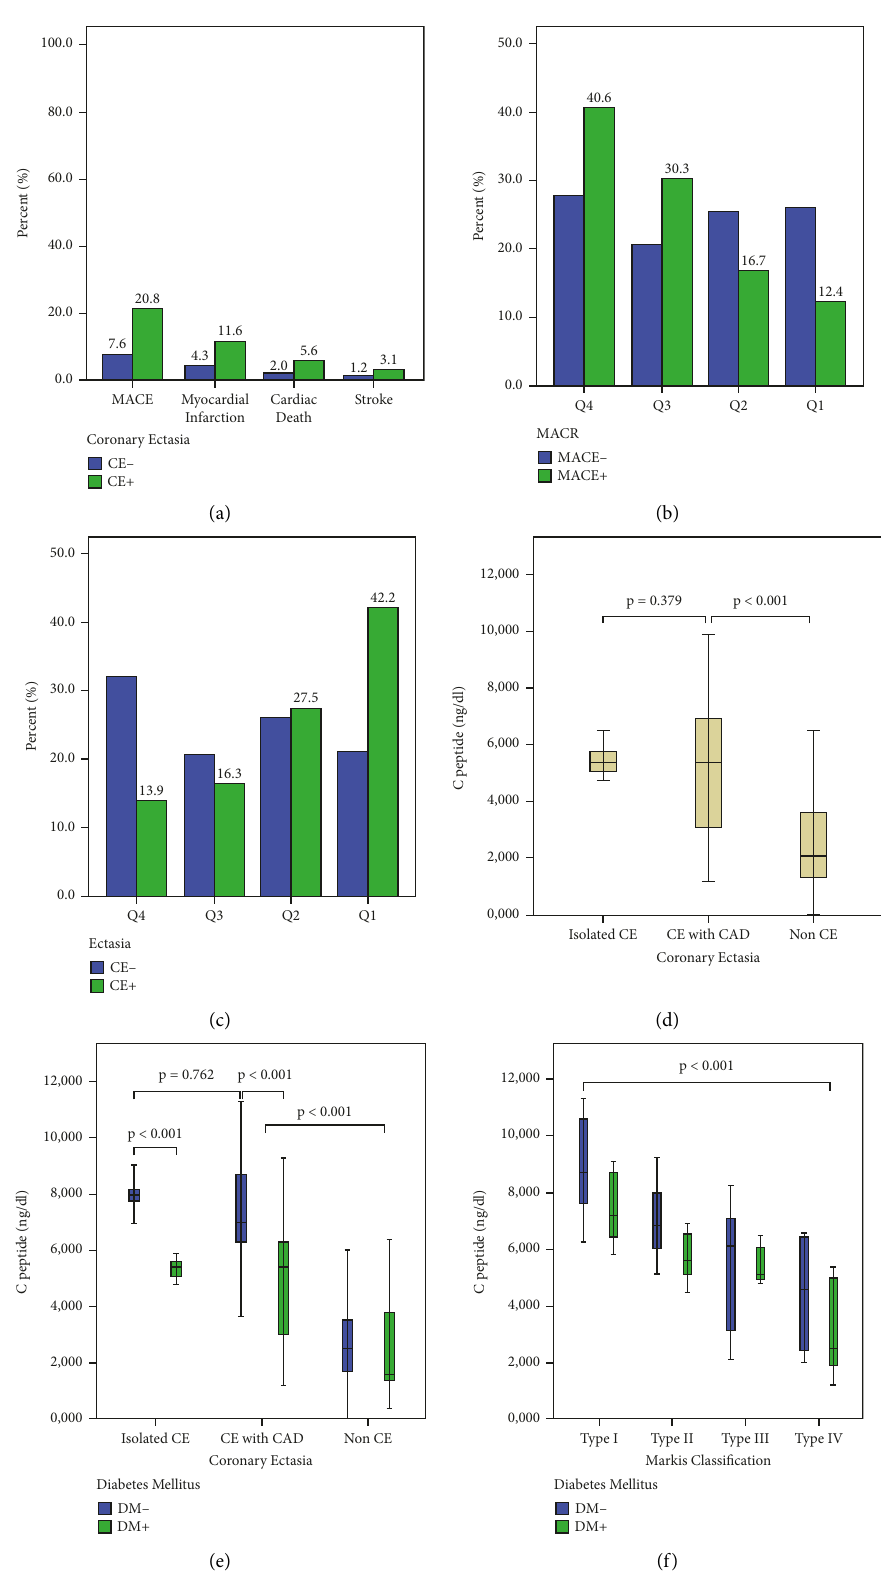
Figure 2: Distribution of individual MACE in patients with and without CAE during follow-up. (b) MACE percentages by C-peptide quartiles. (c) Percentages of coronary ectasia by C-peptide quartiles. (d) Mean C-peptide levels of isolated CAE, CAE with CAD, and non- CAE patient groups. (e) C-peptide levels in isolated CAE, CAE with CAD, and non-CAE patient groups according to DM or not. (f) C- peptide levels according to the presence or absence of DM in the patient groups separated according to the Markis classification. CA, coronary artery ectasia; MACE, major adverse cardiovascular